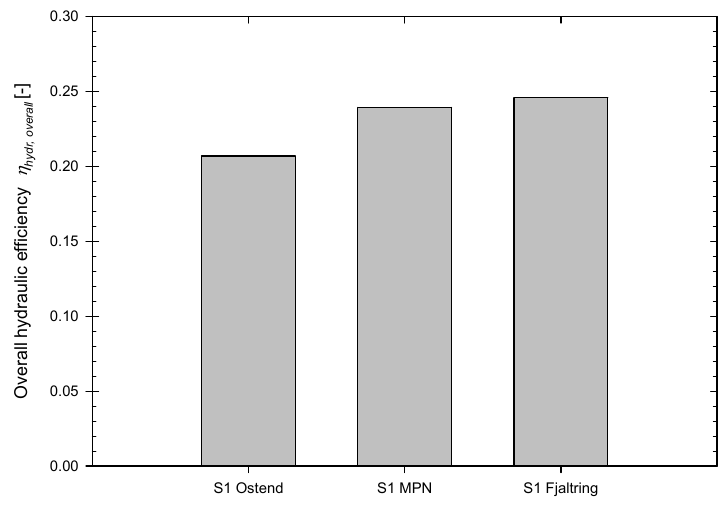
Figure 9. Comparison between mean overall hydraulic efficiency of scenario 1 for test sites in Ostend, MPN and